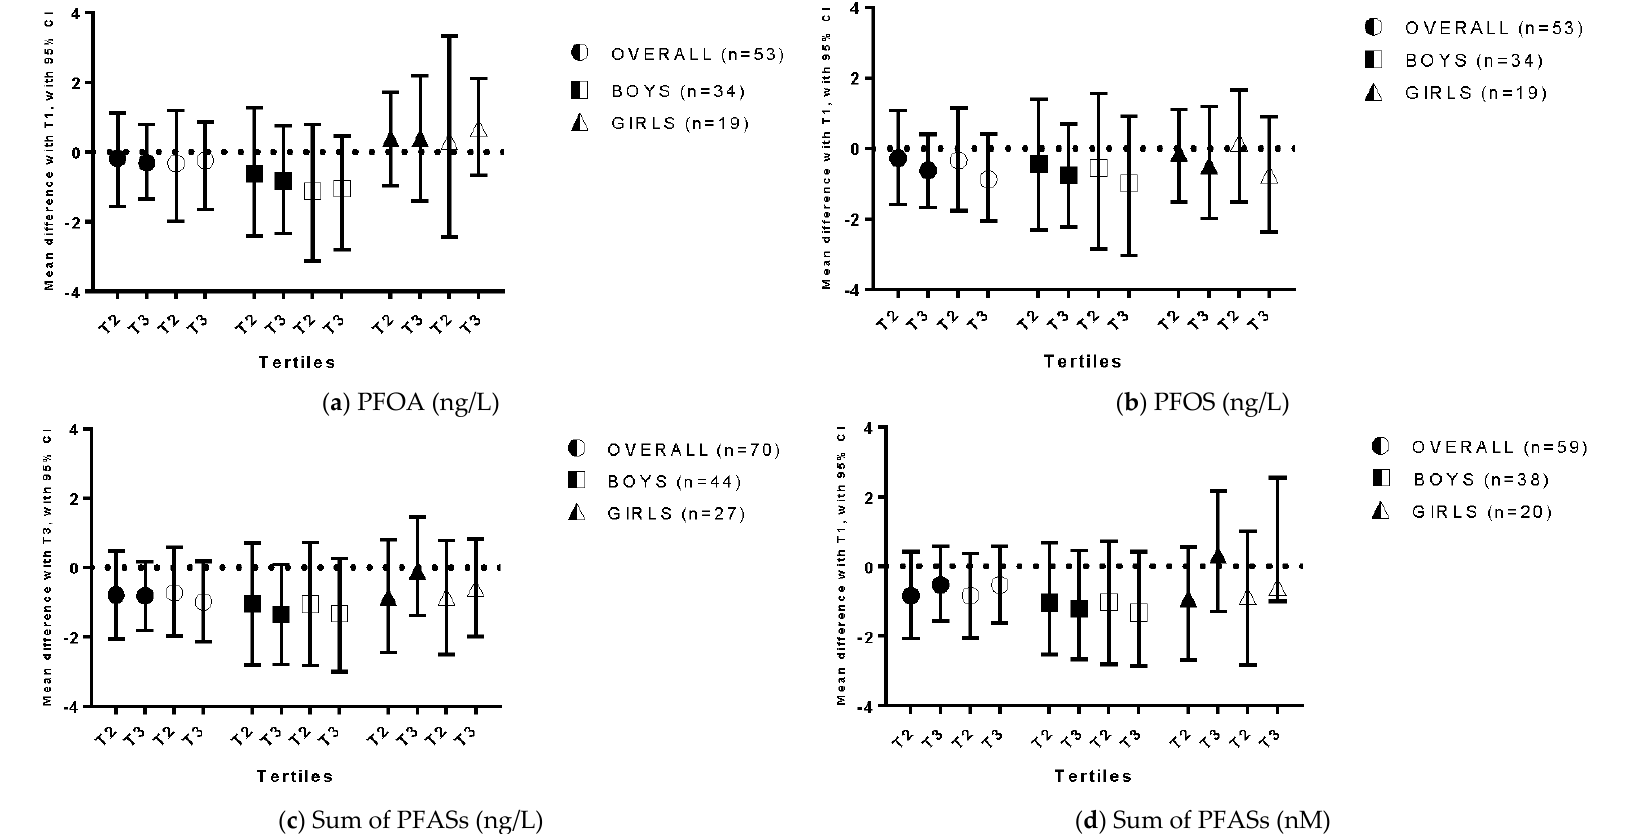
Figure 2. Exposure to perfluoroalkyl substances and scores on the Attention Deficit Hyperactivity Disorder Scale of the Child Behavior Checklist 1.5–5. ( a ) PFOA (ng/L); reported, with T1 as a reference category. Filled symbols represent results from crude analyses, while empty symbols represent results from adjusted analyses.